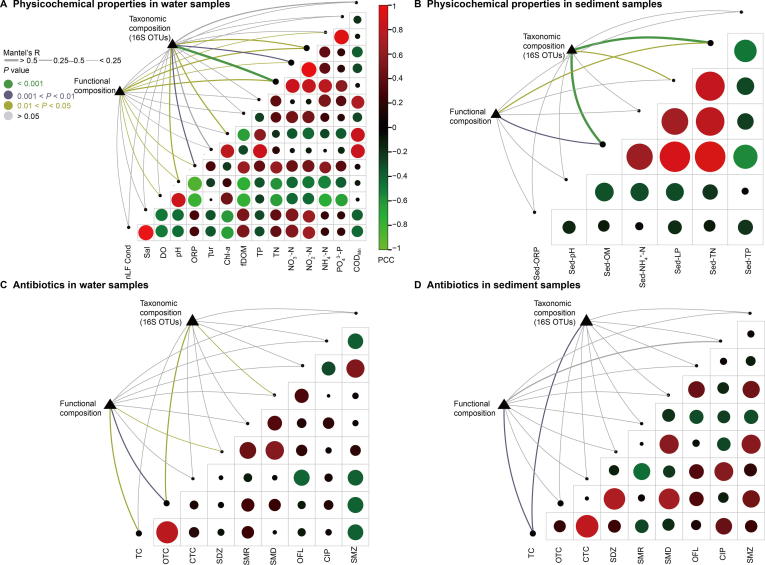
Environmental drivers of microbial community composition in water and sediment samplesPairwise comparison of physicochemical properties with taxonomic and functional composition data in water (A) and sediment (B) samples. Pairwise comparisons of antibiotic concentration data with taxonomic and functional composition data in water (C) and sediment (D) samples. The actual PCC values are indicated in color gradient (with green for lower PCC values and red for higher PCC values), while the absolute PCC values are indicated using circle with bigger size representing higher absolute PCC values between the two factors. The edge width represents Mantel’s R statistic value for distance correlation and the edge color denotes the statistical significance (P values) based on 9999 permutations. PCC, Pearson’s correlation coefficient; nlF Cond, temperature compensated conductivity; Sal, salinity; DO, dissolved oxygen; ORP, oxidation–reduction potential; Tur, turbidity; Chl-a, chlorophyll-a; fDOM, fluorescent dissolved organic matter; TP, total phosphorus; TN, total nitrogen; CODMn, oxygen consumption; OM, organic matter; LP, labile phosphorus; TC, tetracycline; OTC, oxytetracycline; CTC, chlortetracycline; SDZ, sulfadiazine; SMR, sulfamerazine; SMD, sulfadimidine; OFL, ofloxacin; CIP, ciprofloxacin; SMZ, sulfamethoxazole.